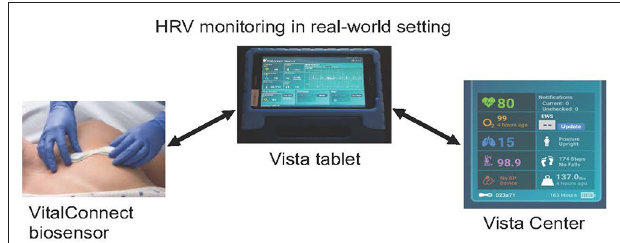
FIGURE 1 | Vista solution platform comprised of (i) a VitalConnect biosensor (single-use, waterproof wireless medical device containing ECG electrodes, applied on the left thorax) that collects unobtrusively, objectively, and continuously 8 vital sign data, including heart rate, (ii) a tablet (Vista tablet, Bluetooth connected), a relay device for bi-directional communications with the biosensor, and (iii) a secured cloud server (Vista center), allowing robust data capture, transfer, and secure storage of encrypted, de-identified patient